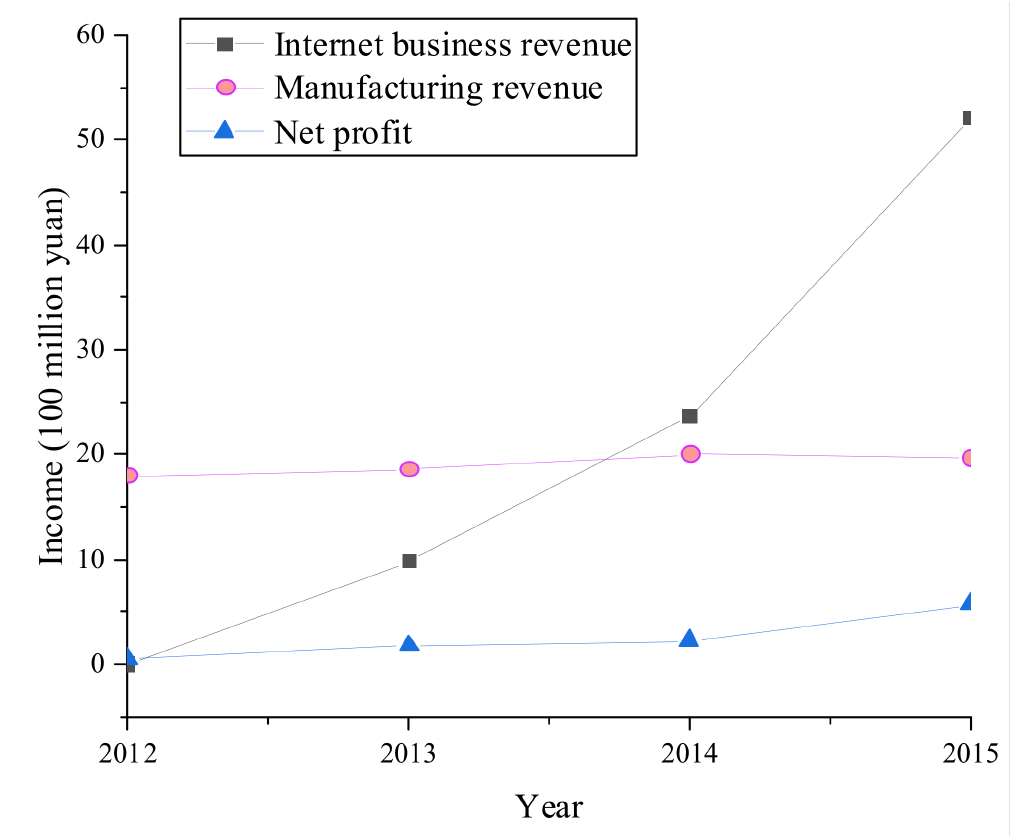
Figure 8. Changes in enterprise financial data during BYD’s